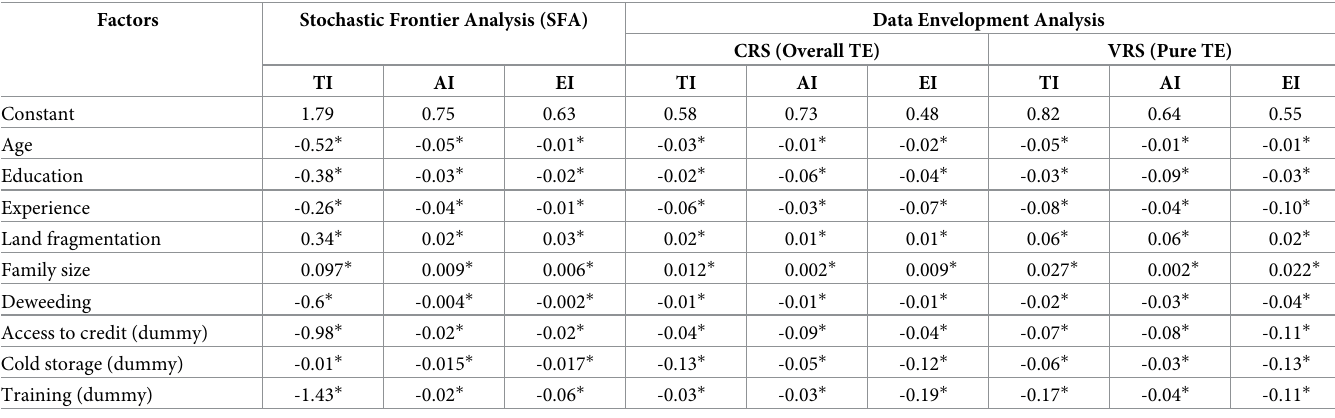
Fig 1. Mean efficiency of economic, technical and allocative obtained by SFA and DEA methods. https://doi.org/10.1371/journal.pone.0284391.g001 Table 3. Coefficients of factors affecting